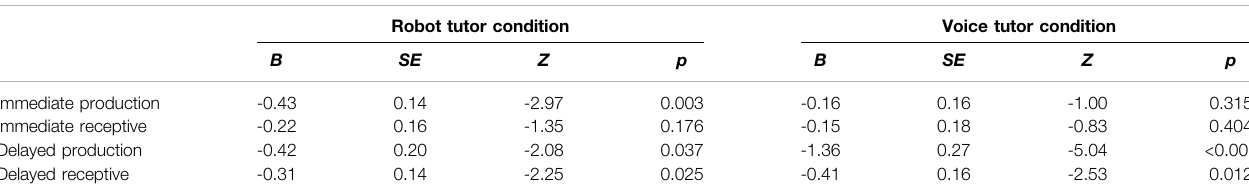
TABLE 5 | GLMMs with L2 Anxiety as the sole predictor for the four post-lesson